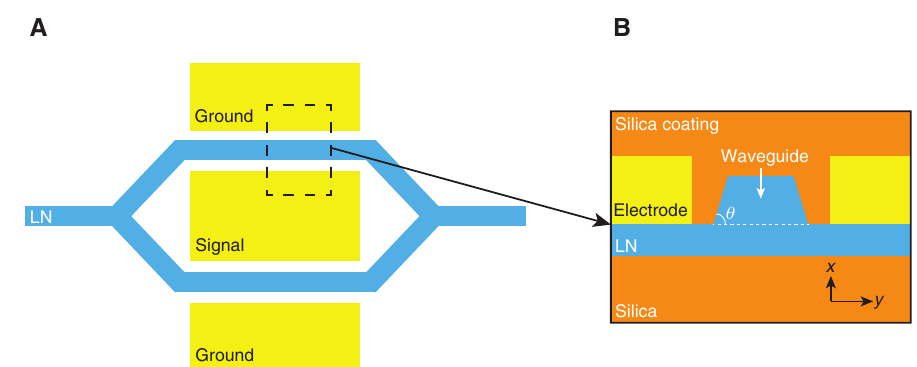
Figure 16: Schematic diagrams of an integrated LN MZI electro-optic modulator. (A) and (B) shows the top view and cross-section view,